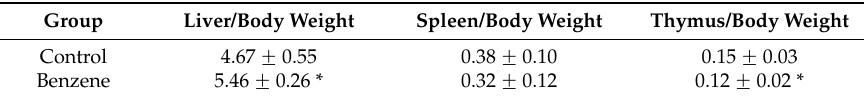
Table 2. Blood parameters of mice in benzene exposure and control groups.